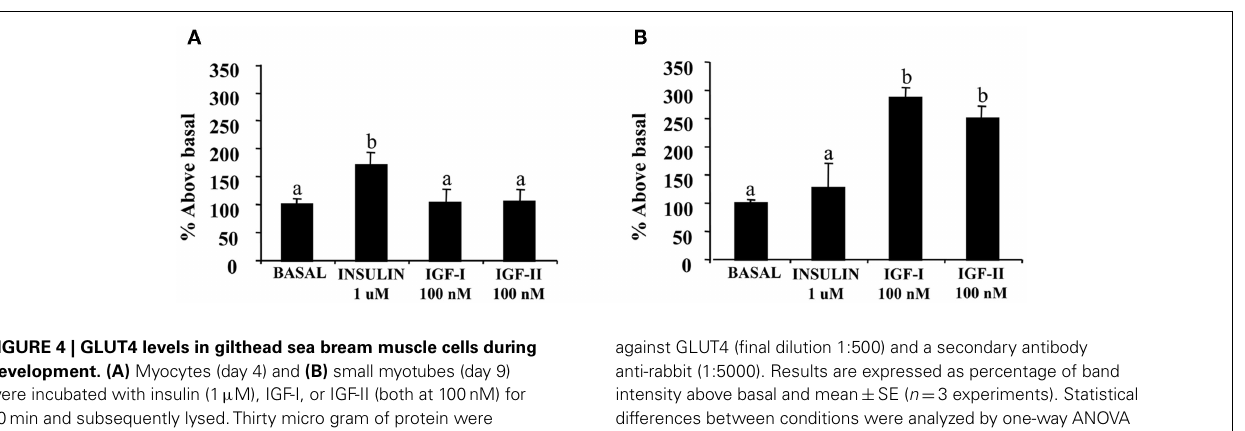
FIGURE 4 | GLUT4 levels in gilthead sea bream muscle cells during development. (A) Myocytes (day 4) and (B) small myotubes (day 9) were incubated with insulin (1 μ M), IGF-I, or IGF-II (both at 100nM) for 60min and subsequently lysed.Thirty micro gram of protein were loaded in each lane and subjected to 10% SDS-PAGE under reducing conditions.Western blot was performed with a primary antibody